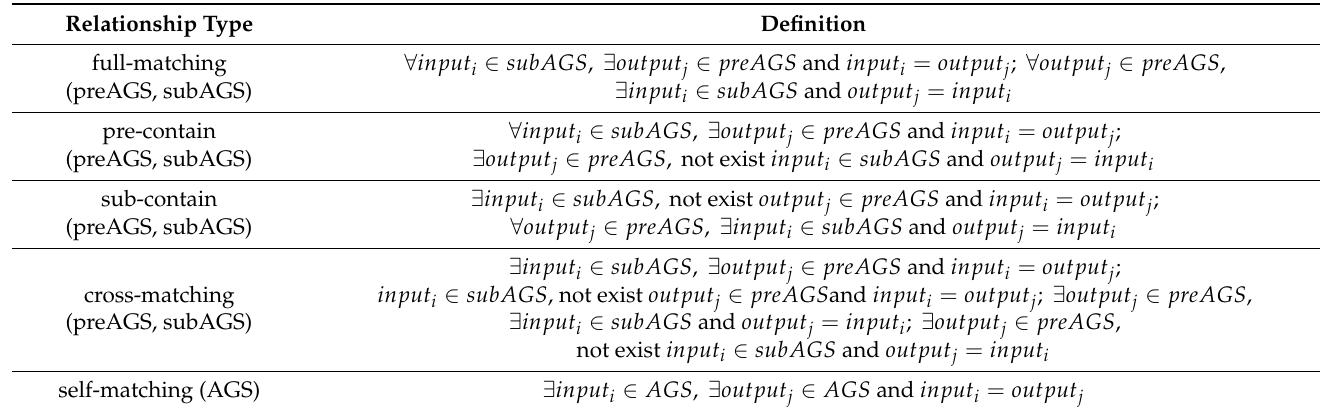
Table 2. Abstract geospatial service relationship definition.